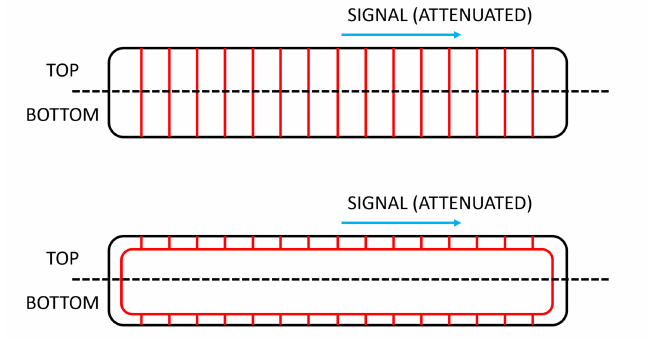
Figure 2 . Entanglement growth in two different situations. In the upper diagram, entanglement between the top and the bottom will grow rapidly, at a rate proportional to the length of the wire. However, the chaotic wires will still not be able to convey any simple signal. In the lower diagram, attenuation of simple signals will continue to take place as in situation in the upper diagram, but now the system obeys a microscopic speed limit and entanglement between the top and the bottom will grow much more slowly, at a constant rate independent of wire length.